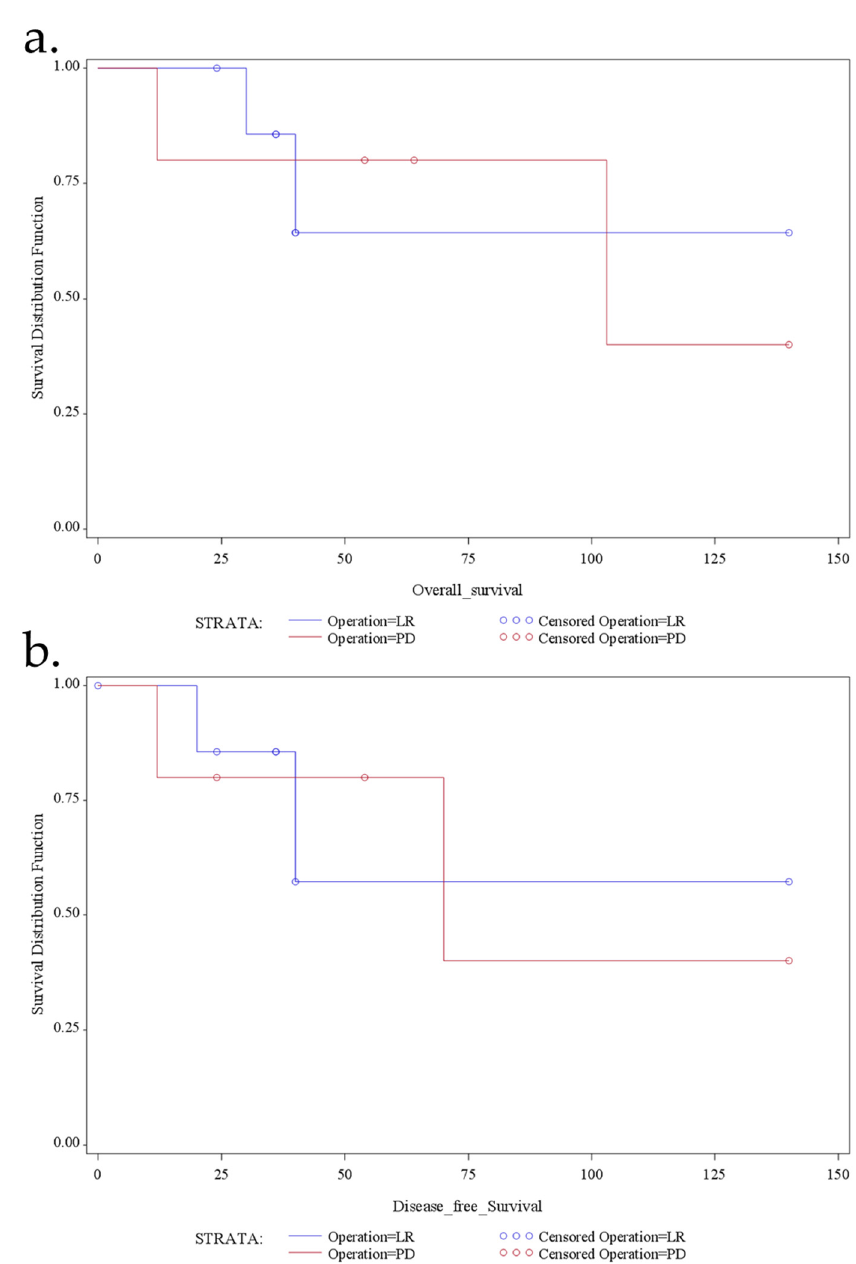
Figure 3. Kaplan–Meier estimator shows the overall survival ( a ) and the disease-free survival ( b ) for the patients with duodenal GIST and comparing LR and PD.